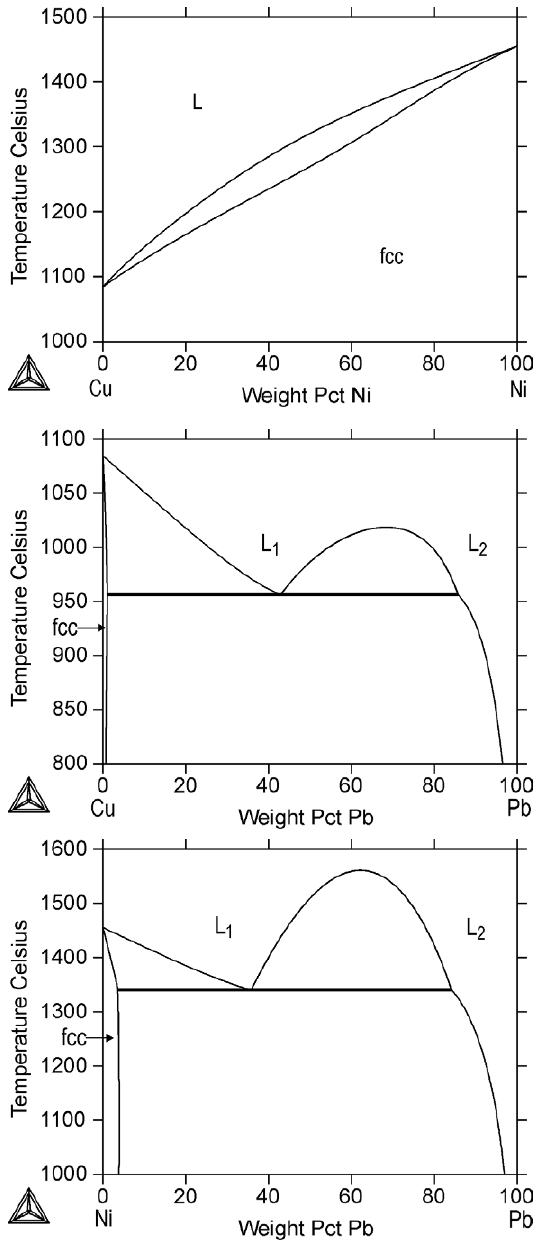
Figure 1. Calculated phase diagrams of binaries Cu-Ni (a), Cu-Pb (b) and Ni-Pb (c) up to [36], [37] and [24],